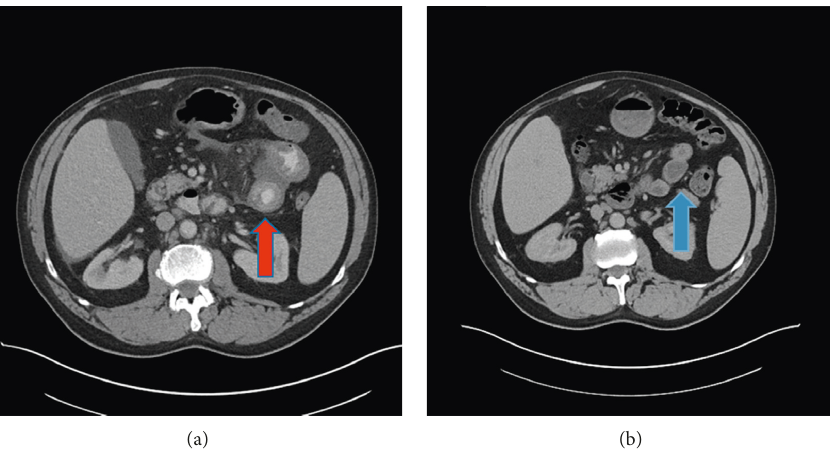
Figure 2: CT abdomen findings before and after treatment. (a) Before treatment, the patient was noted to have jejunal enteritis, which is indicated by the target sign (red arrow). (b) After treatment, the patient had resolution of jejunitis (blue